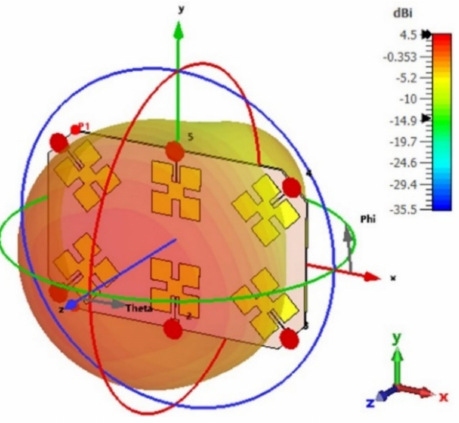
Figure 11. The simulated 3D radiation pattern of Ant 1, Ant 3, Ant 4, and Ant 6 at 2.45 GHz.